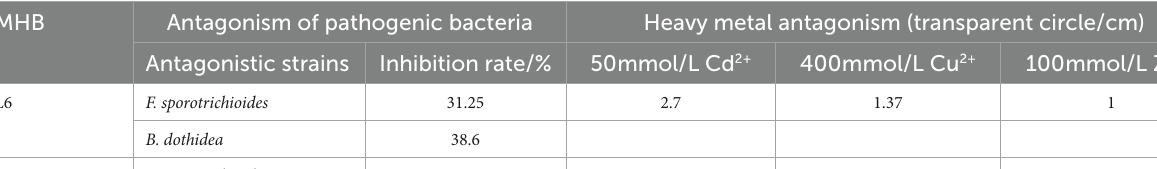
TABLE 3 Analysis of resist stress ability of L6 and LM3.